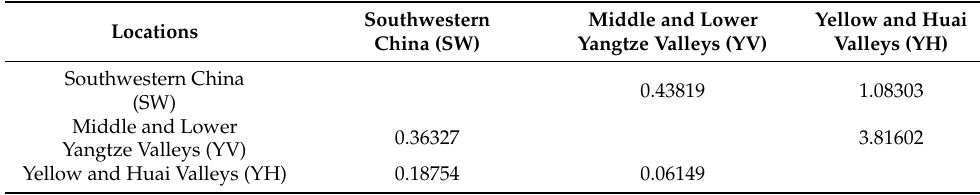
Table 6. Pairwise F ST (below diagonal) and gene flow N m (above diagonal) among different geo- graphic regions of P. major based on